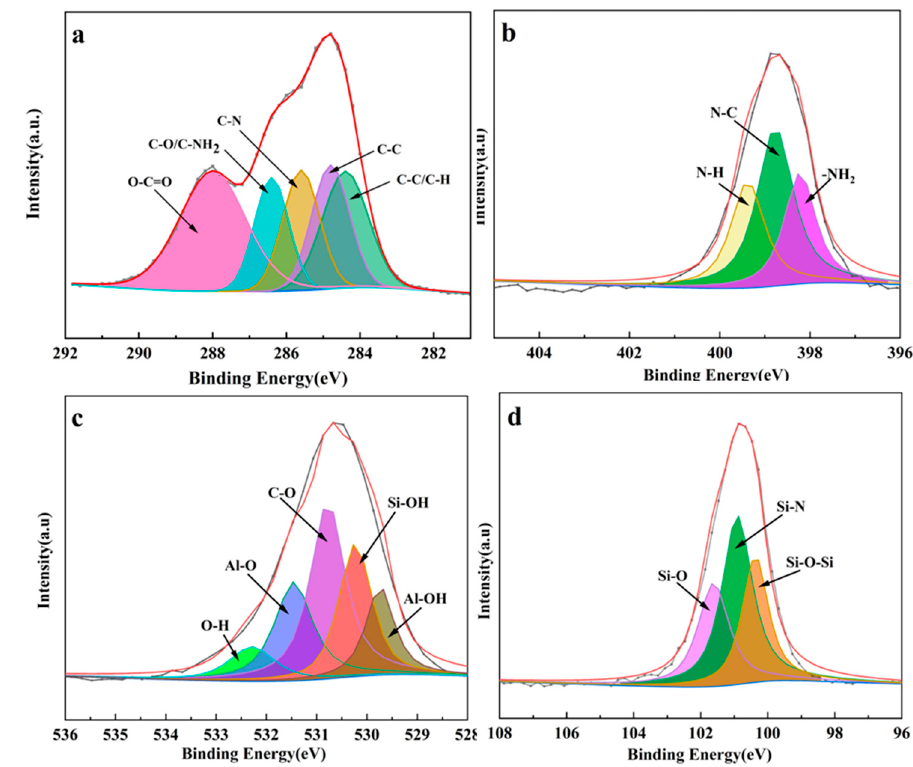
Figure 6. C1s ( a ), N1s ( b ), O1s ( c ), and Si2p ( d ) spectra of the SF/GEL/KA-N/AgNWs fi lm.